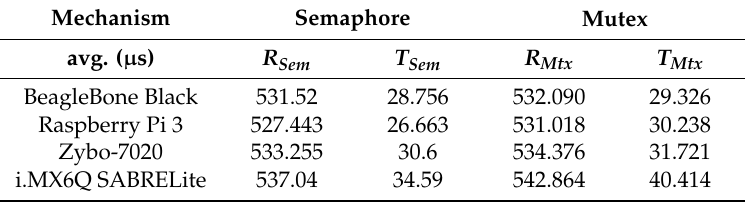
Table 4. Statistical average of the shared memory ITC mechanisms, semaphore and mutex.